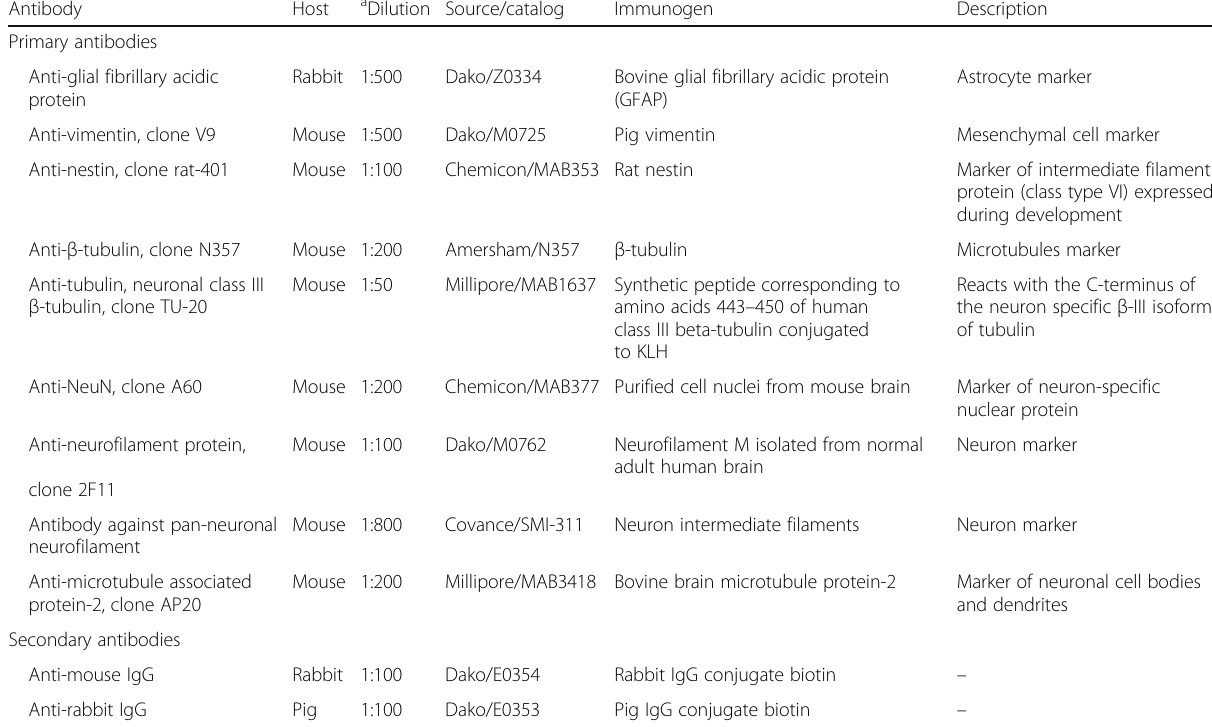
Table 1 Antibodies used in the present immunohistochemistry assays Antibody Host a Dilution